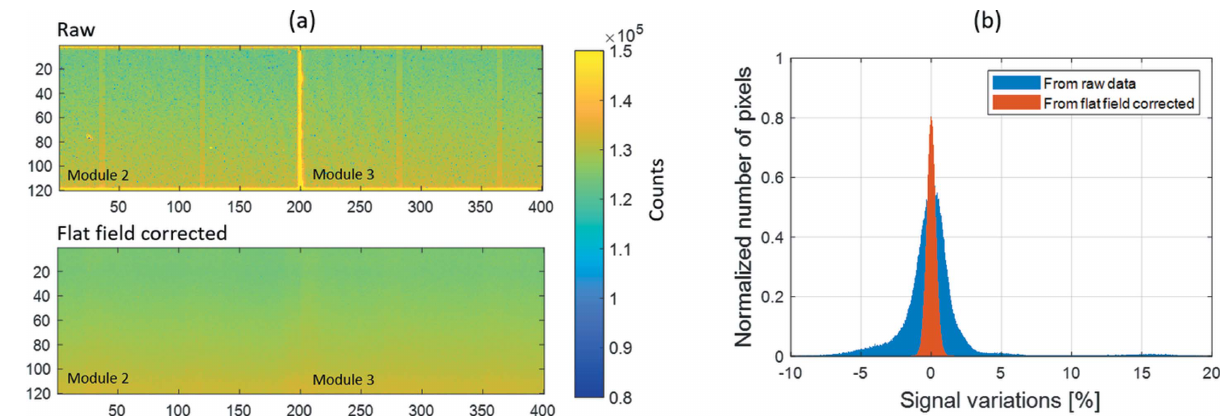
Figure 10 ( a ) Raw (top) and flat-field corrected (bottom) ROI images of 120 (cid:2) 400 pixels between modules 2 and 3. ( b ) Histogram of the pixel-to-pixel variation for the complete detector for the raw and corrected